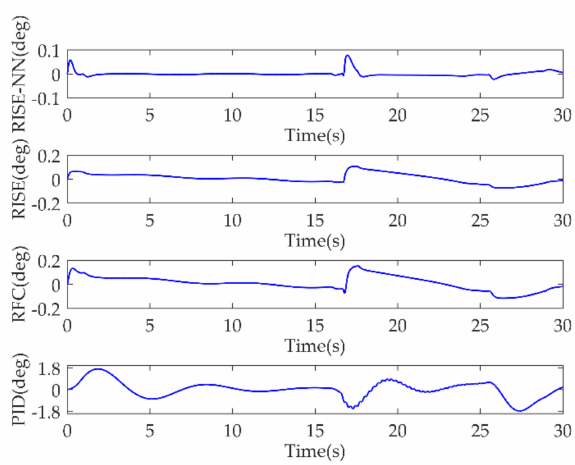
Figure 16. Tracking errors of the four controllers in case